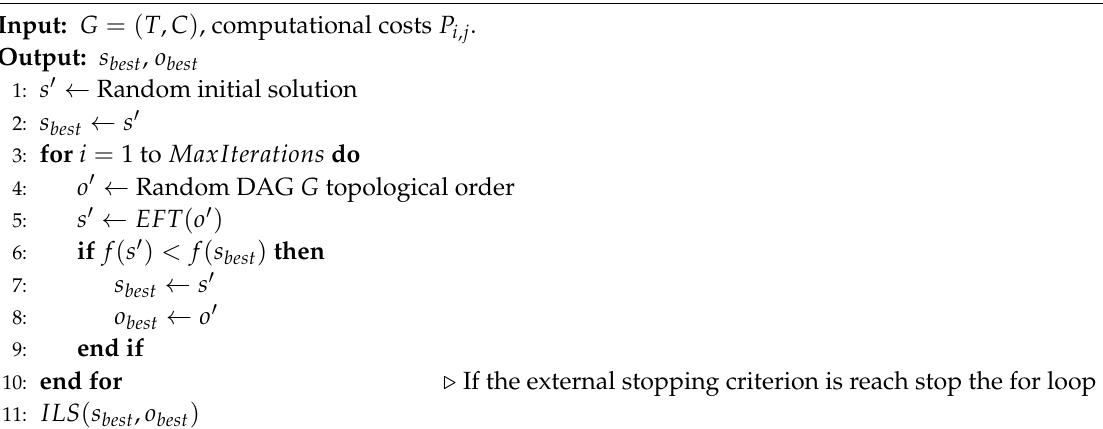
Algorithm 4 Earliest Finish Time-Iterated Local